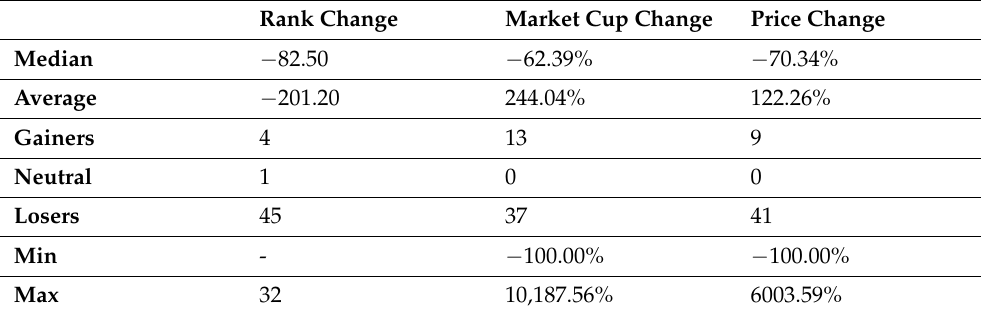
Table 1. Summation of market position changes between 1 January 2018 and 1 January 2022 for the 50 highest market cup cryptocurrencies as of 1 January